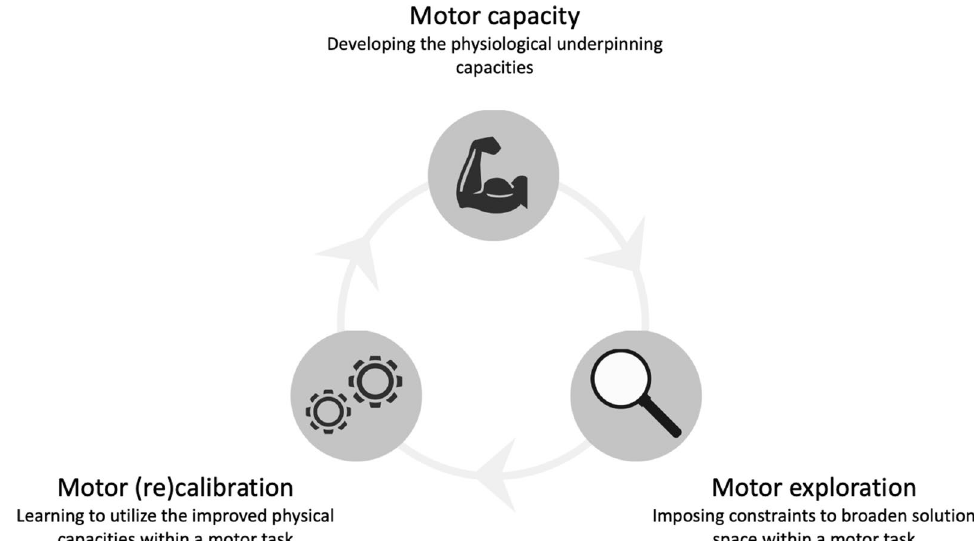
Fig. 4 Continuous iterative (re)calibration framework of learning to transfer and express strength gains in